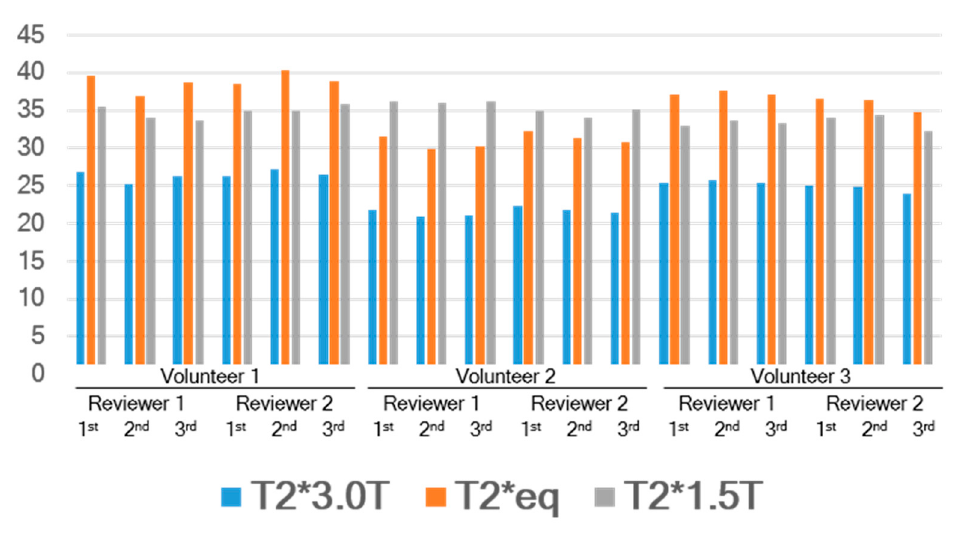
Figure 3. T2* values in three healthy volunteers with repeated measures by two radiologist readers. T2* 3.0T = T2* measured at 3T, T2* eq = equivalent T2* calculated from the site-specific equation, T2* 1.5T = T2* measured at 1.5T.